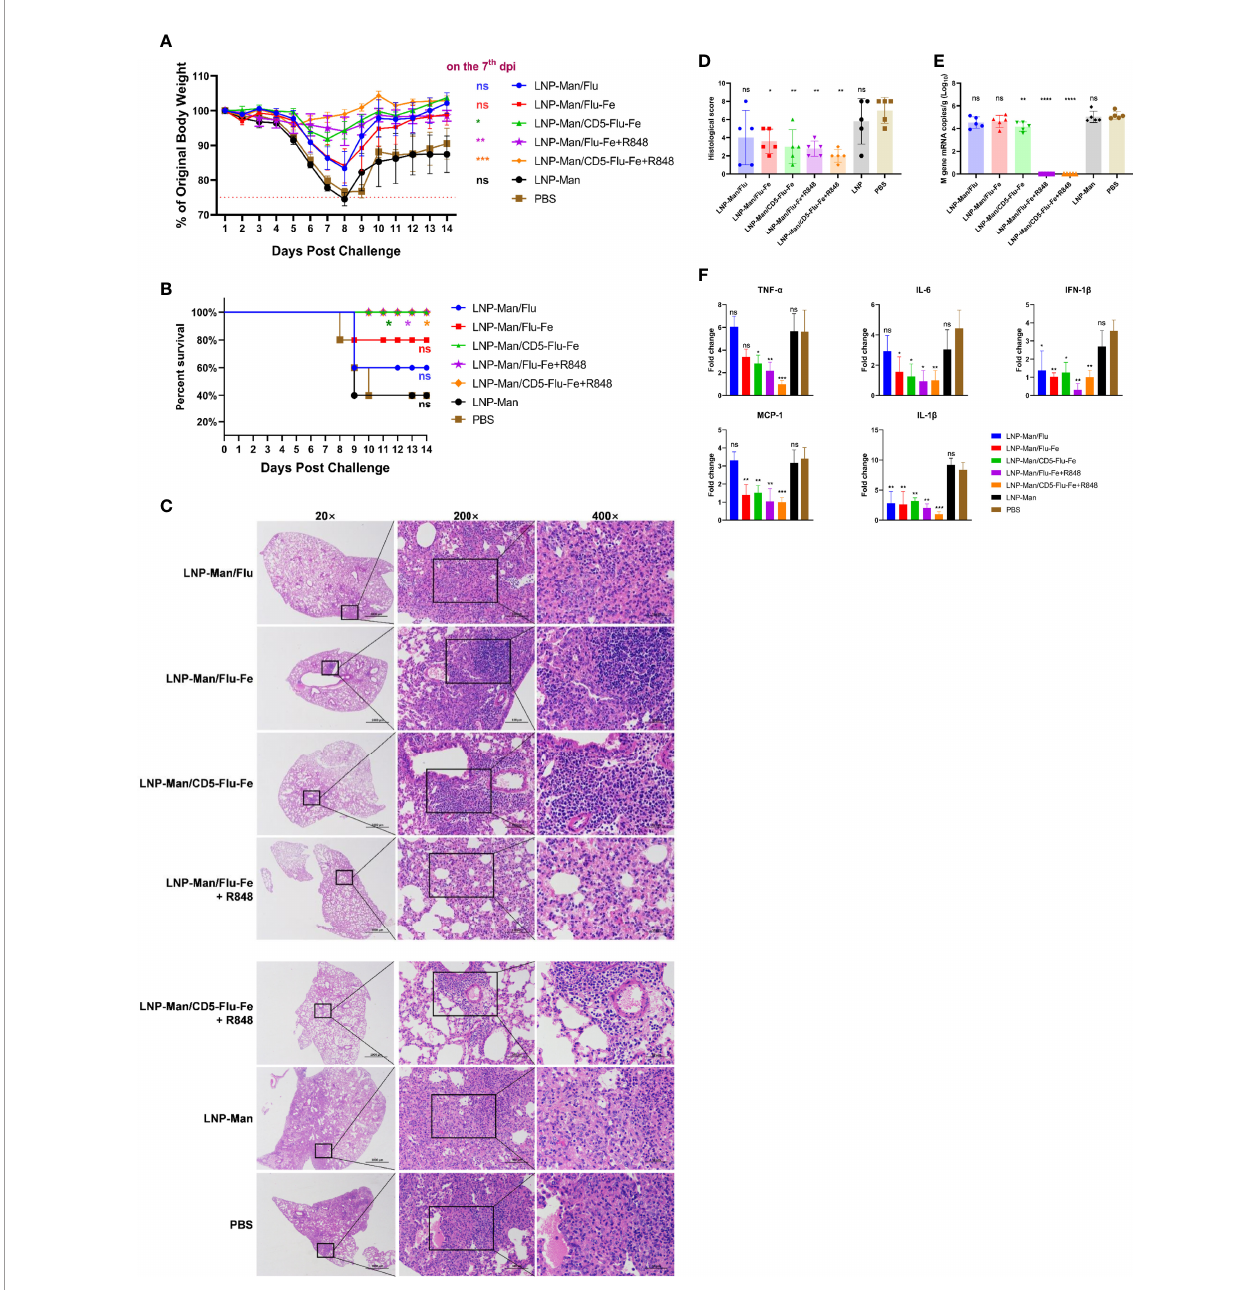
FIGURE 6 | Analysis of protective effect of mRNA vaccines after challenge. After the third immunization, the C57BL/6 mice were challenged with H5N1 in fl uenza virus at the dose of 1×LD 50 . The body weight (A) and survival rate (B) of mice were monitored for 14 days. Survival analyses were performed using the log-rank (Mantel – Cox) test. (C) Representative images of H&E-stained lung sections on the 5th day postinfection (dpi). n=5 for each group. (D) Results of histology scores. The viral loads (E) and the relative expression of cytokines/chemokines (F) in lung homogenate in each group on the 5th dpi were determined by real-time RT-PCR. Fold changes of the genes expression were relative to the lung samples in the LNP-Man/CD5-Flu-Fe+R848 group. Data were shown as mean ± SDs and were analyzed by one ‐ way ANOVA. Statistically signi fi cant differences are indicated in colors corresponding to the vaccine group (n=5, ns p > 0.05; *p < 0.05; **p < 0.01; ***p < 0.001; ****p < 0.0001 when compared with the PBS